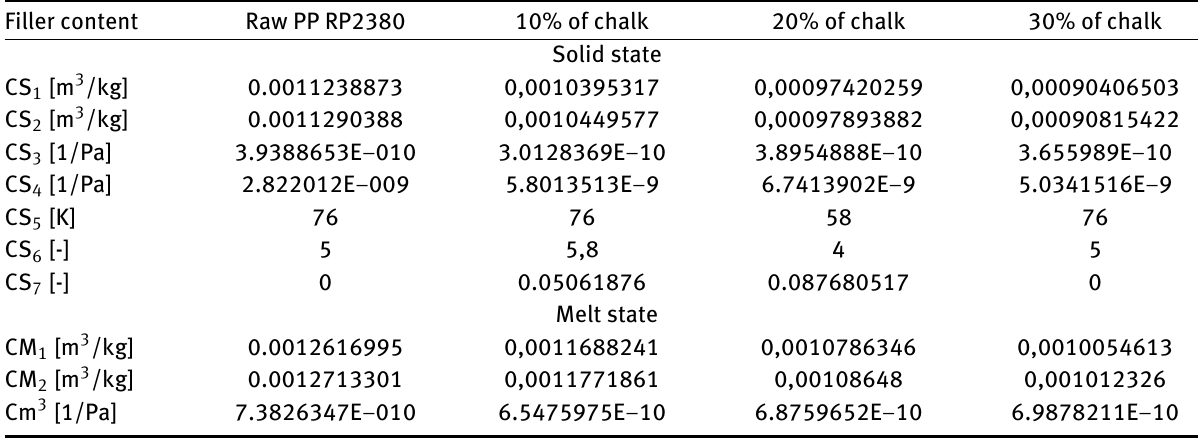
Table 1: Renner equation coeflcients versus filler content